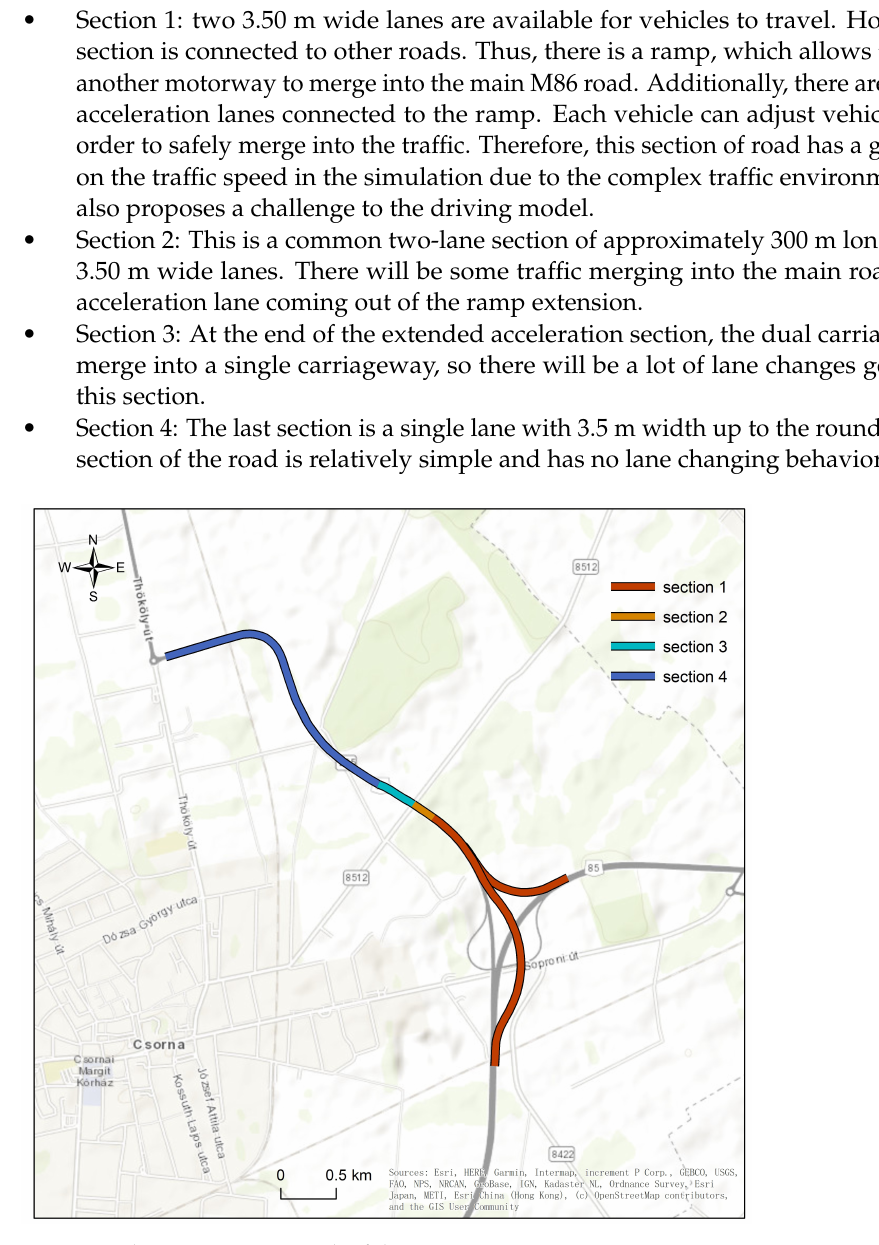
Figure 9. The upstream network of the M86